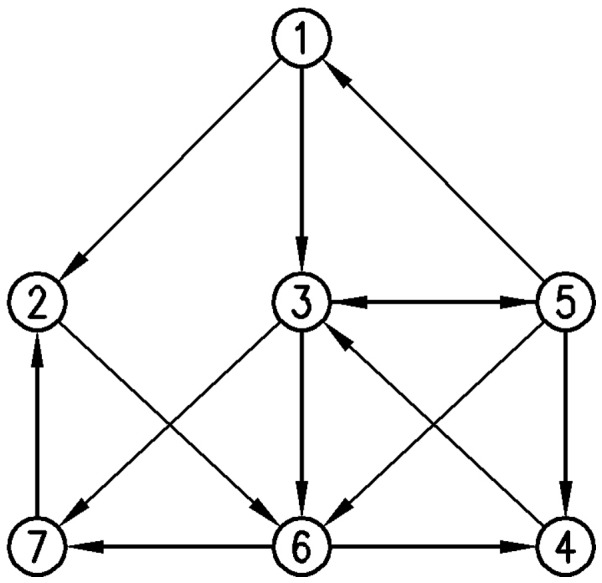
An instance of a network.